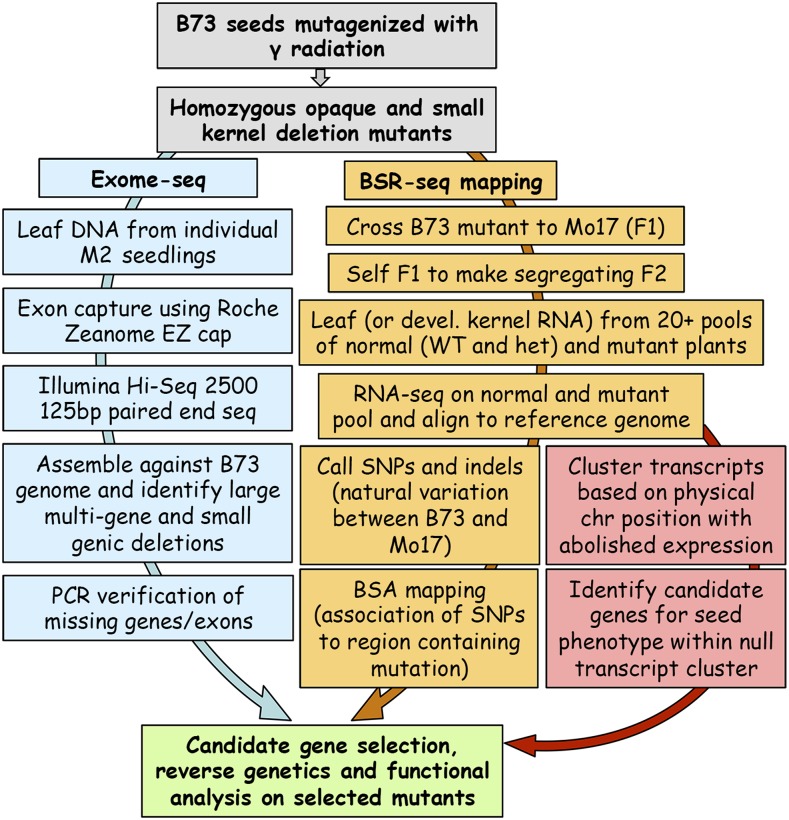
BSREx-seq workflow.